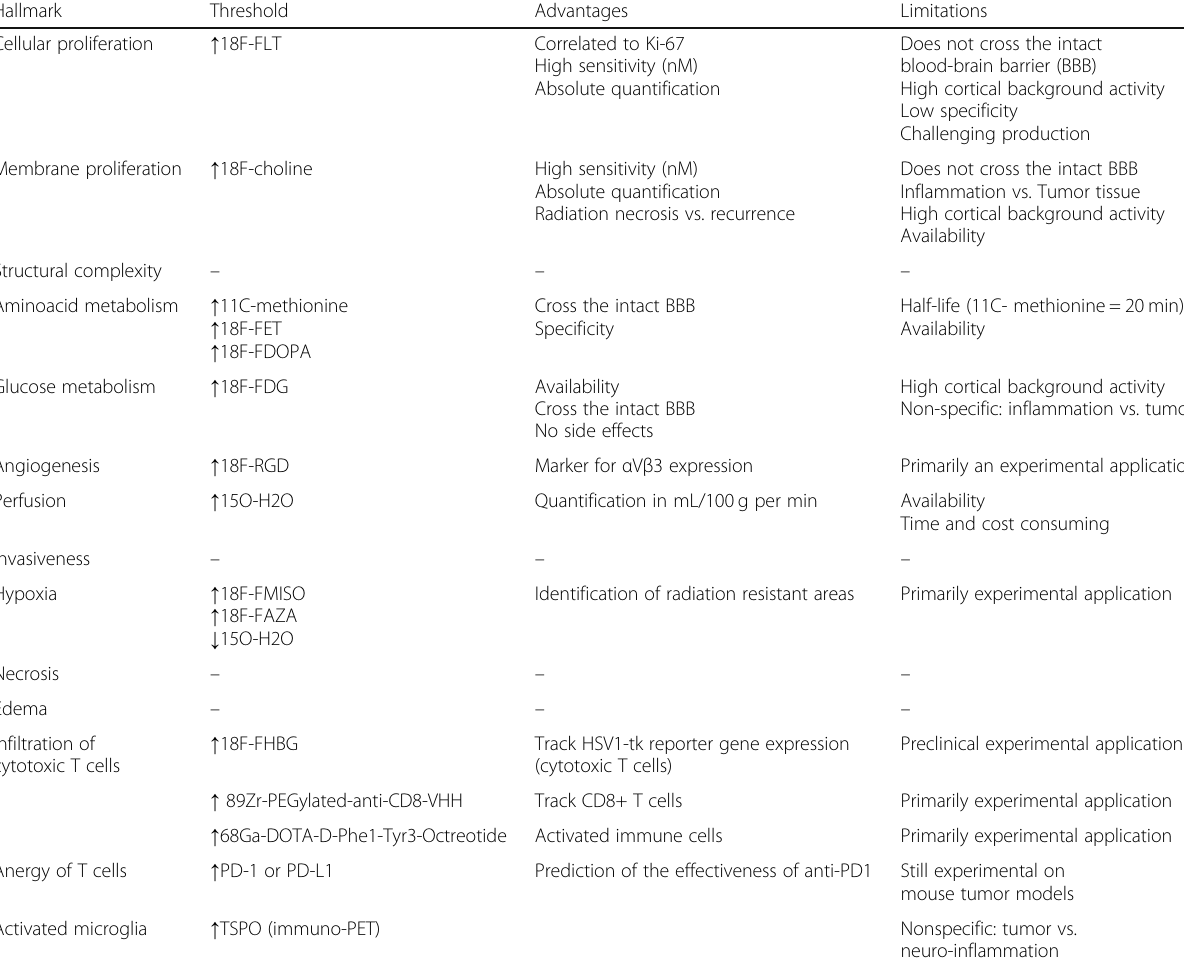
Table 3 PET imaging biomarkers for assessment of the immune and tumor environment of gliobastoma